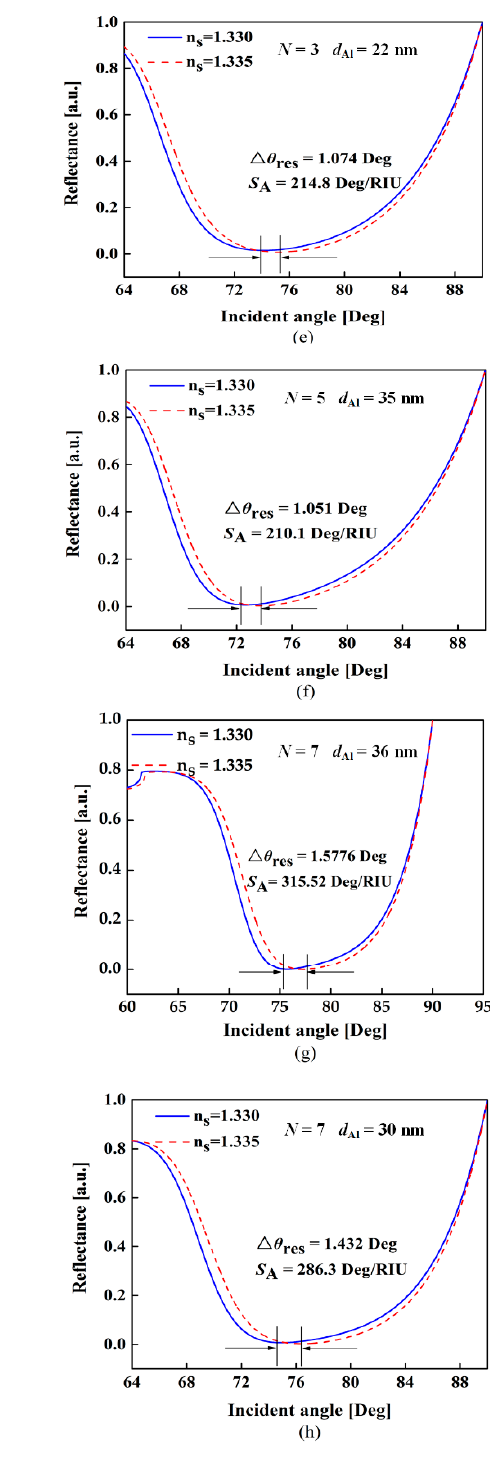
Figure 2. ( a – d ) Variation of the angular sensitivity as a function of the number of MX 2 layers N with various thickness of Al thin film d Al and ( e – h ) the reflection spectra with different TMDCs materials under optimal structures.